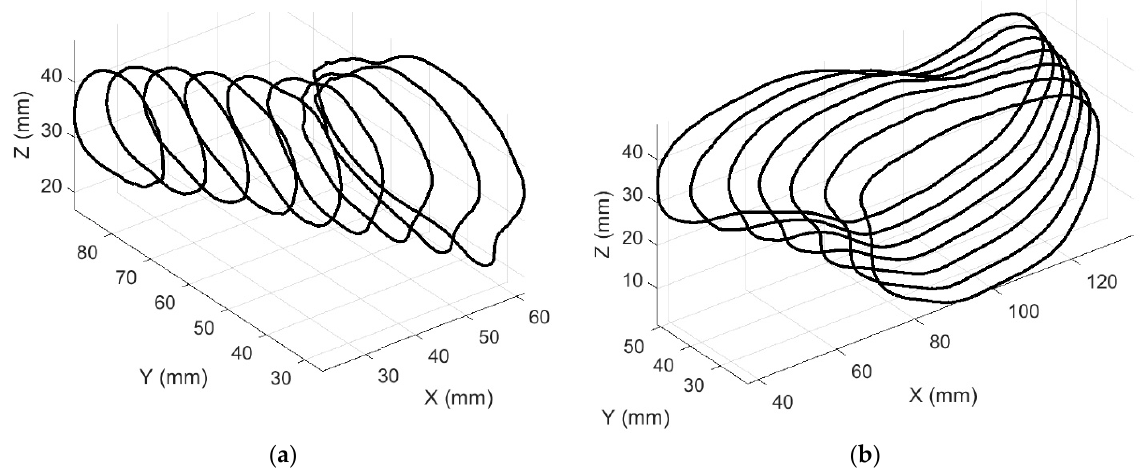
Figure 9. Boundaries from cross sections generated for Zone 1 and Zone 2: ( a ) Boundaries in Zone 1; ( b ) Boundaries in Zone 2.